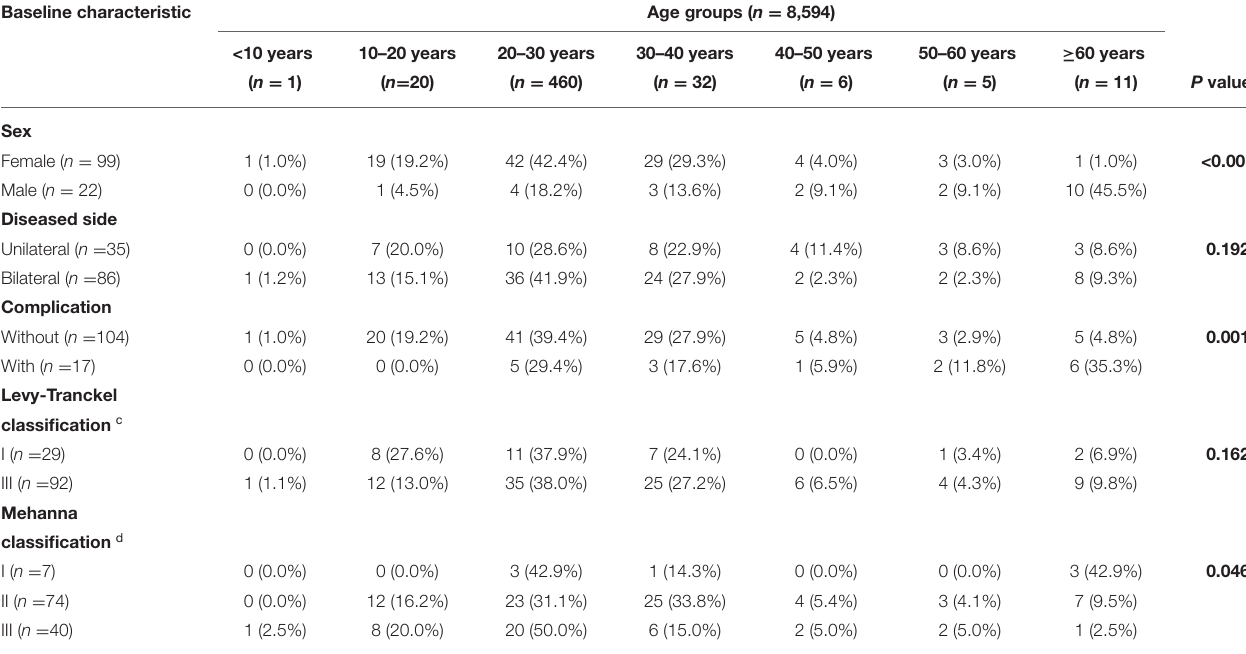
TABLE 1 | Characteristics of the patients included in the study ( n = 121) by age a . Baseline